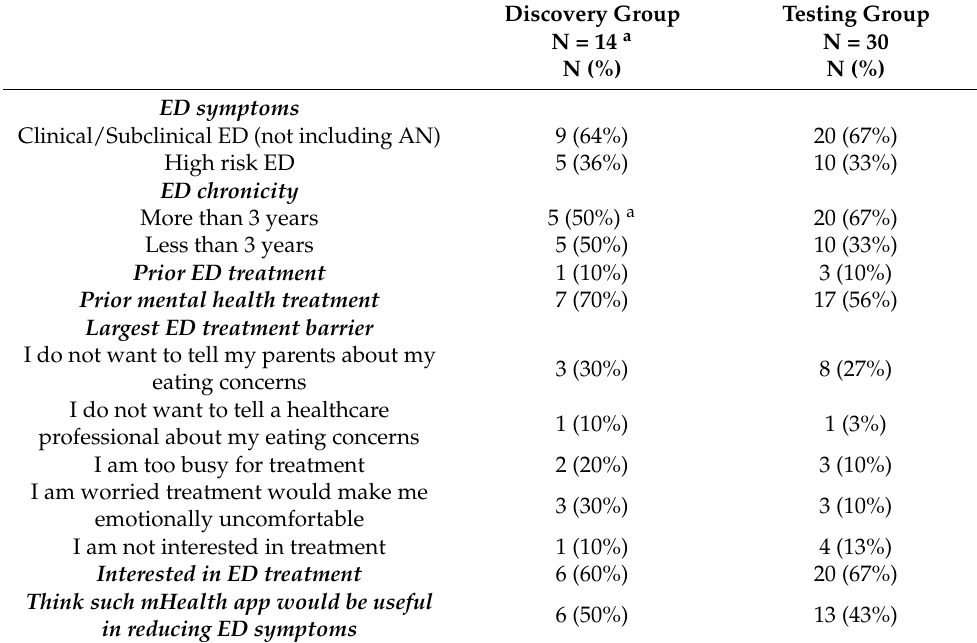
Table 2. Discovery and Testing Group ED symptoms and treatment.